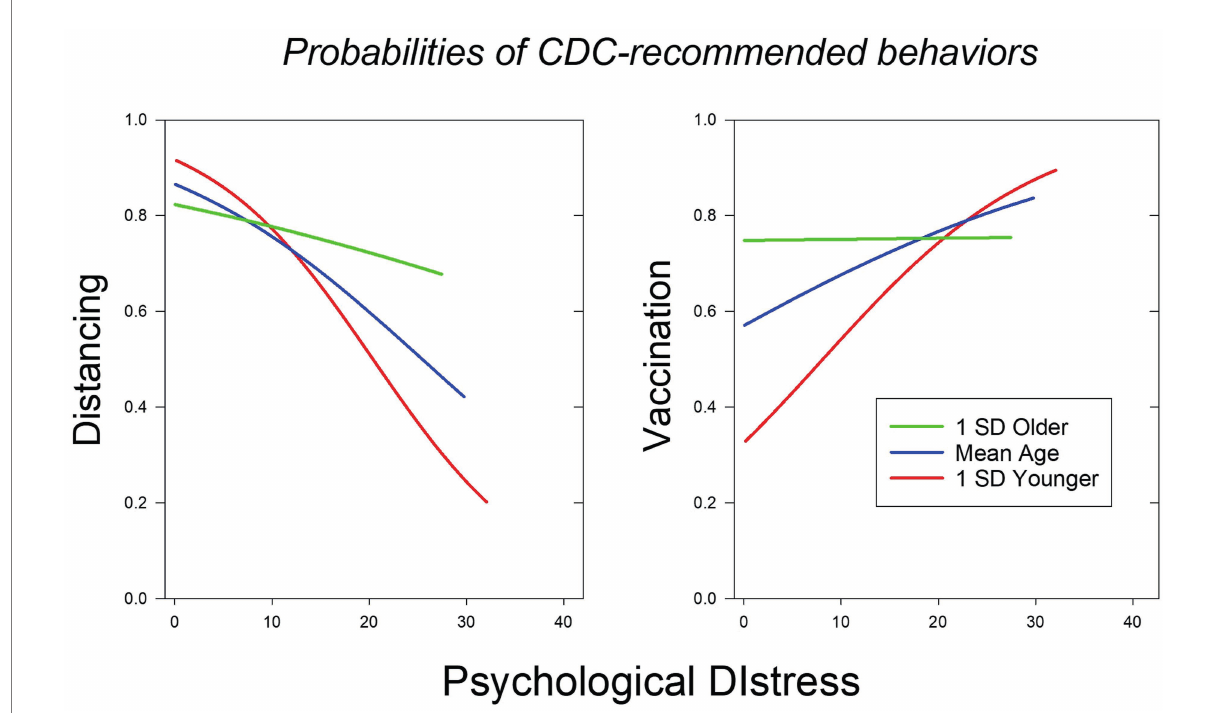
FIGURE 3 The probability that a participant decreased the frequency of close interactions (left panel) and the probability that they were vaccinated (right panel) as a function of their age and HADS score. The blue, red, and green lines depict the probabilities for a participant of average age in the sample, one whose age was 1 SD below the mean, and one whose age was 1 SD above the mean, respectively. For each age, probabilities are depicted for HADS scores up to two SDs above the mean (maximum possible score =